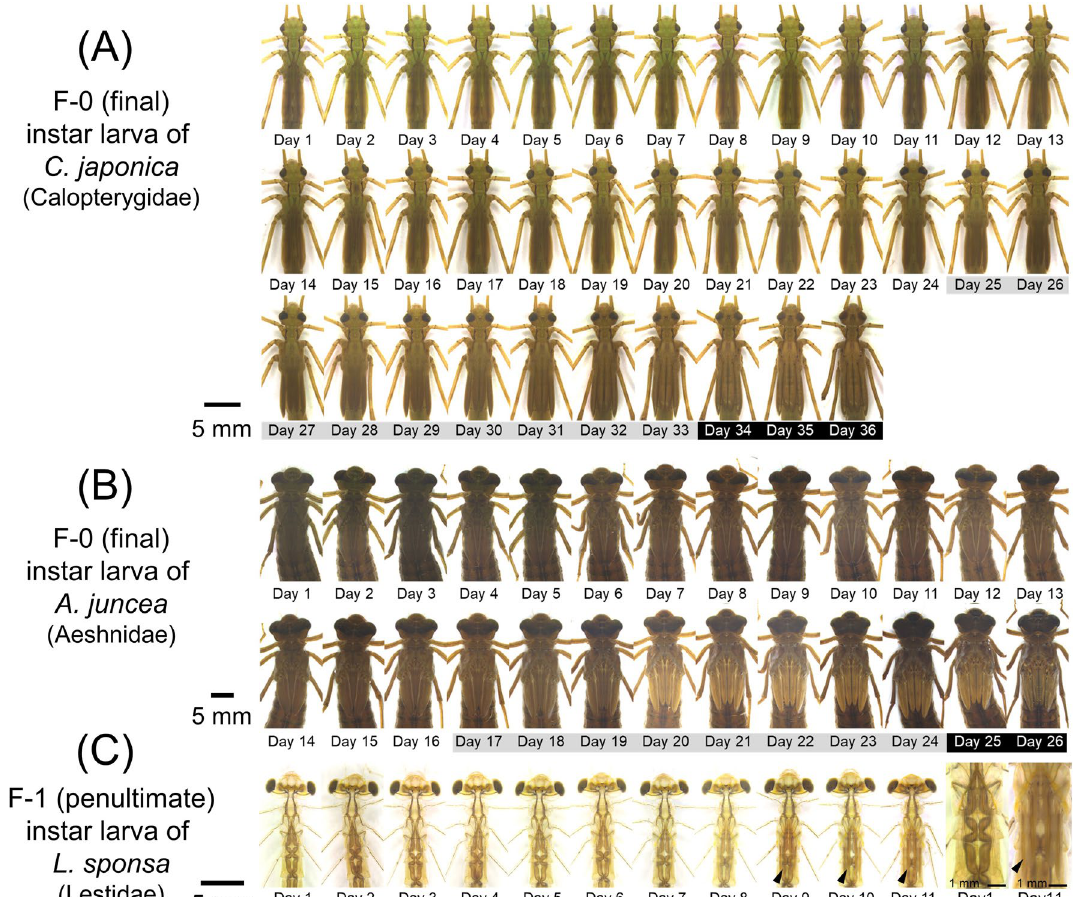
Figure 2. Examples of daily photos obtained in this study. For all photos, see Figs. S2 and S3. The higher quality photos are deposited in the Dryad Digital Repository: https ://doi.org/10.5061/dryad .tht76 hdz6. ( A ) F−0 instar female larva of Calopteryx japonica (Calopterygidae, Zygoptera). Adult emergence was observed on Day 37. ( B ) F−0 instar larva female of Aeshna juncea (Aeshnidae, Anisoptera). Adult emergence was observed on Day 27. ( C ) F−1 instar female larva of Lestes sponsa (Lestidae, Zygoptera). Ecdysis to F−0 instar was observed on Day 12. Black arrowheads indicate the expansion of the wing sheaths. Day numbers shaded in gray or black indicate stage 2 or 3,